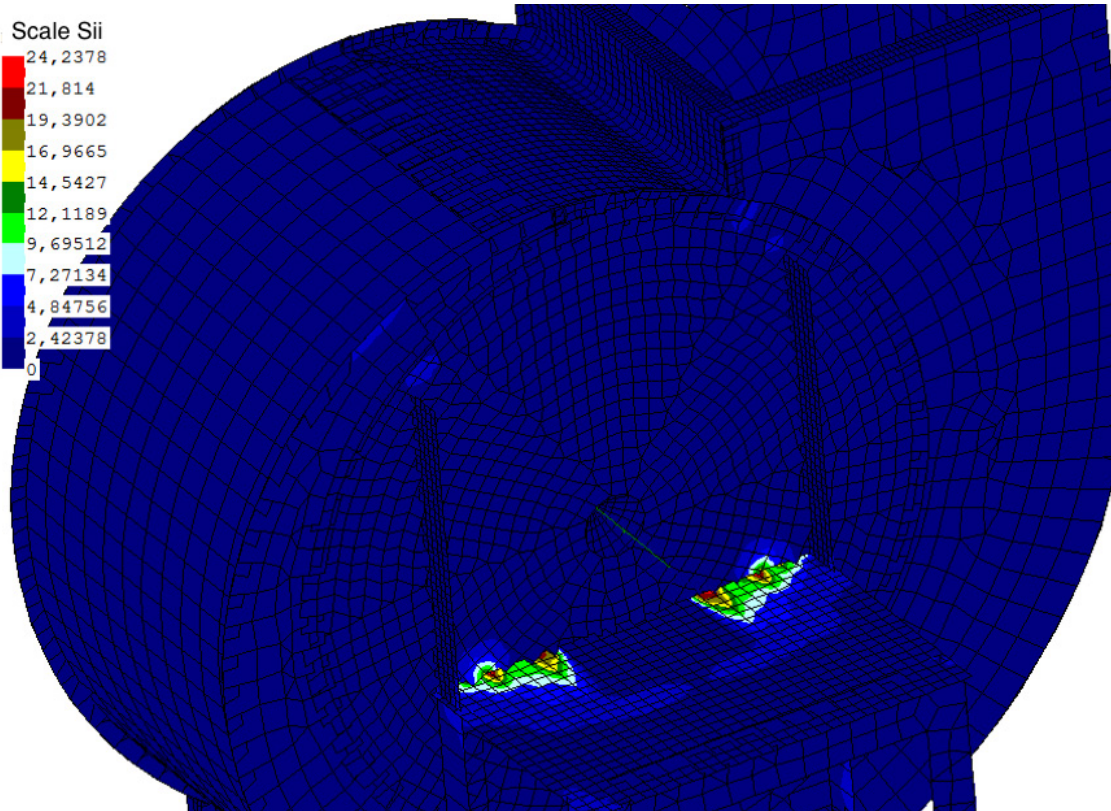
Figure 4. Amplitude values of reduced stresses calculated for the ventilator by the dynamic analysis method, MPa.